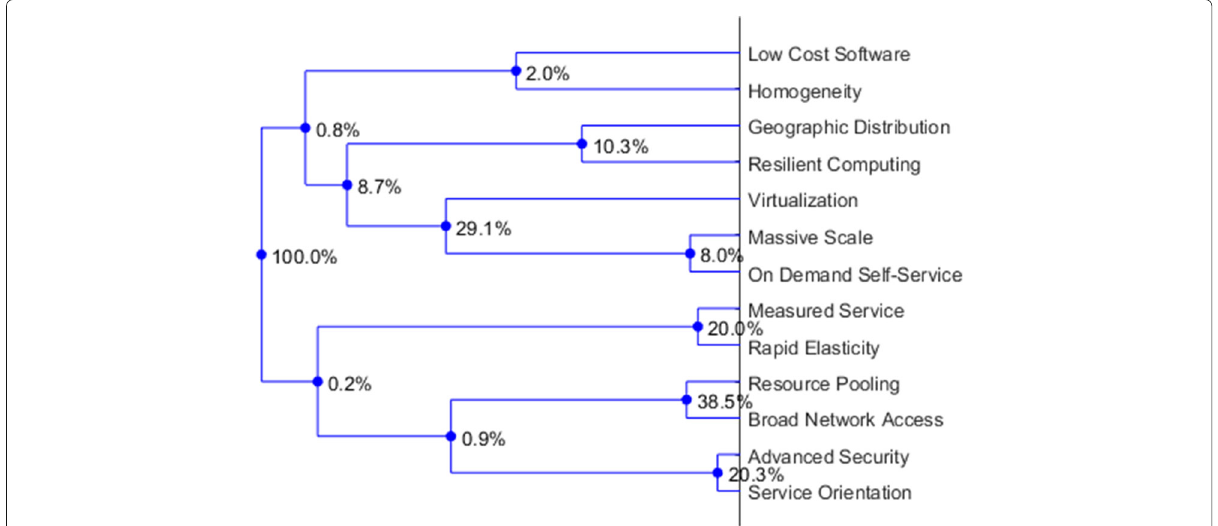
Fig. 3 Hierarchical dendrogram of variables in a 4-dimensional representation of the decomposition of the full 13-dimensional dataset. Advanced Security and MassiveScale are shown at opposite ends of the tree connected only by the deepest node, consistent with the view in the 2-d biplot. MeasuredService and GeographicDistribution , shown very close together in 2-d, are in fact very distant when considering more relevant dimensions. Internal nodes are labelled with bootstrap percentages indicating the proportion of times in 1000 bootstrap replicates of the CA analysis that a node is observed. All values are <50%, with many values much smaller, indicating that this solution is not robust to bootstrap resampling. i.e. no grouping shown here is strongly supported by